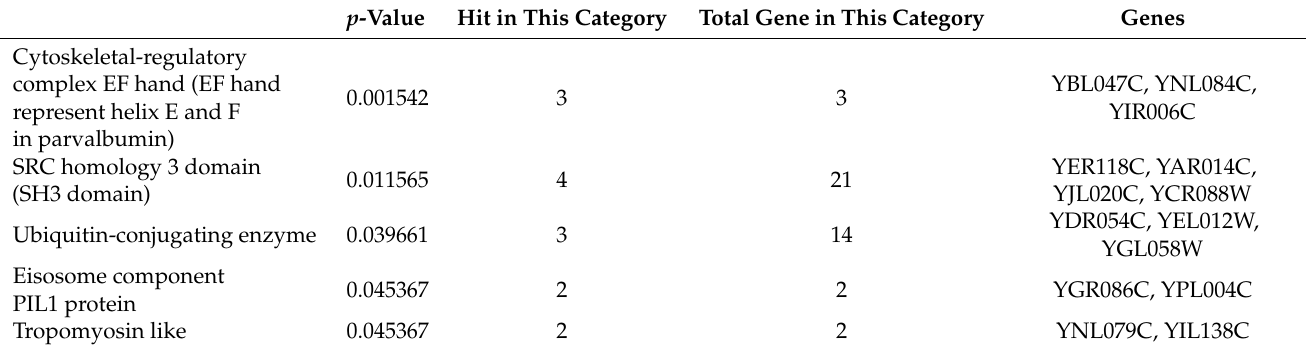
Table 4. Enrichment categories in protein domain analyzed by PFAM for the protein targets of Sub5.